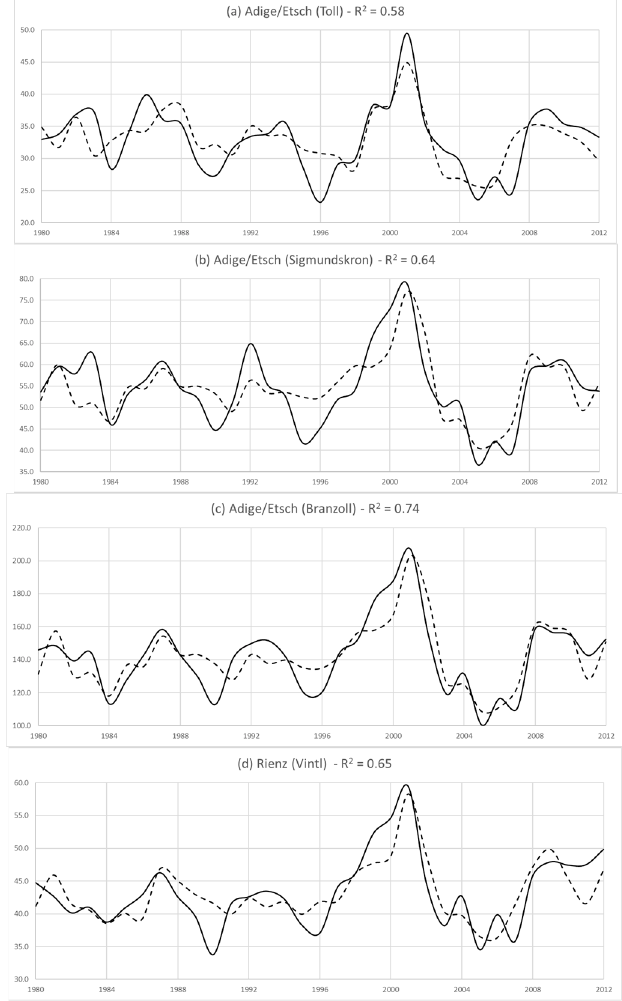
Figure 2. Observed (solid line) and SLR modeled (dashed line) annual flowrate (m 3 /s) from 1980 to 2012 for ( a ) Adige/Etsch (Toll), ( b ) Adige/Etsch (Sigmundskron), ( c ) Adige/Etsch (Branzoll), and ( d ) Rienz (Vintl). Coefficient of Determination (R 2 ) is provided.